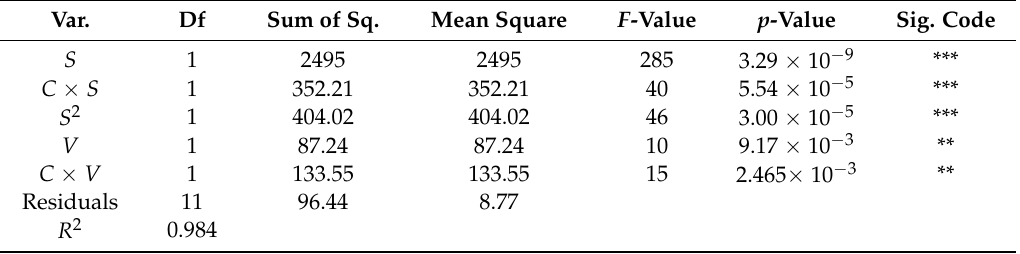
Table 3. ANOVA table for the “ A ” quadratic model.